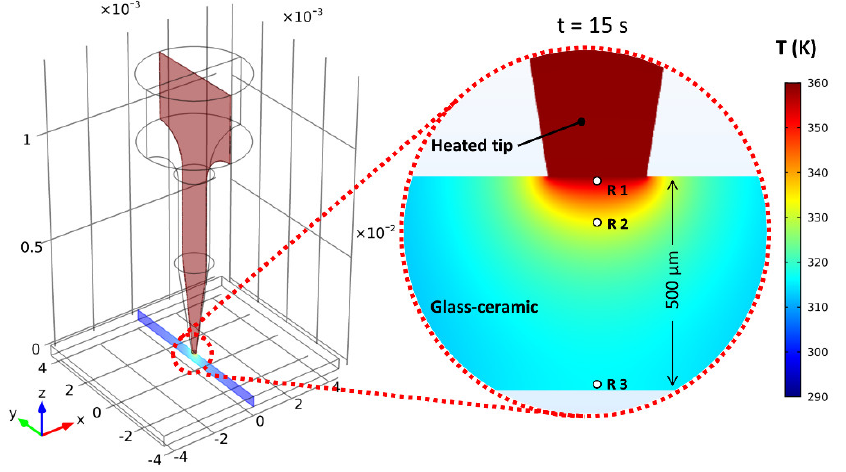
Figure 5. Simulated two-dimensional temperature distribution in the transparent glass-ceramic sample after the electrical resistive heating for 15 s with an electrical heater turned on for 7 s.